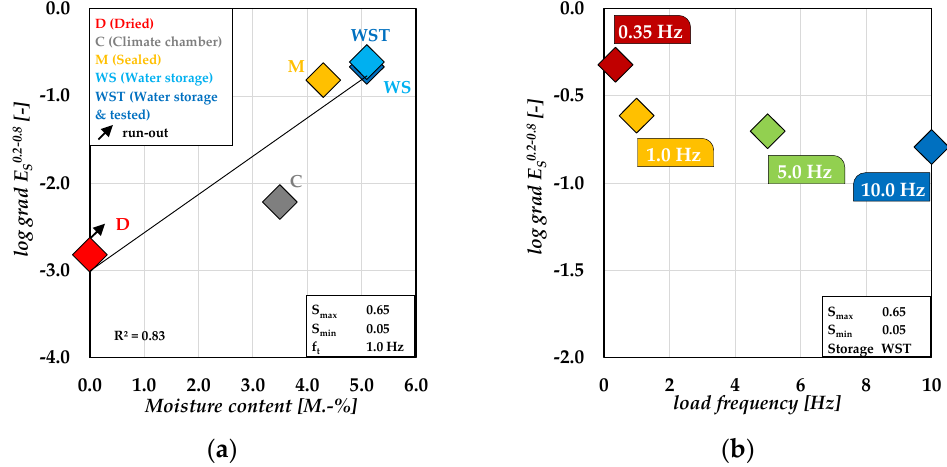
Figure 3. Logarithmic gradient of stiffness in phase II depending on the moisture content ( a ) [22] and depending on the load frequency for storage condition WST ( b ).